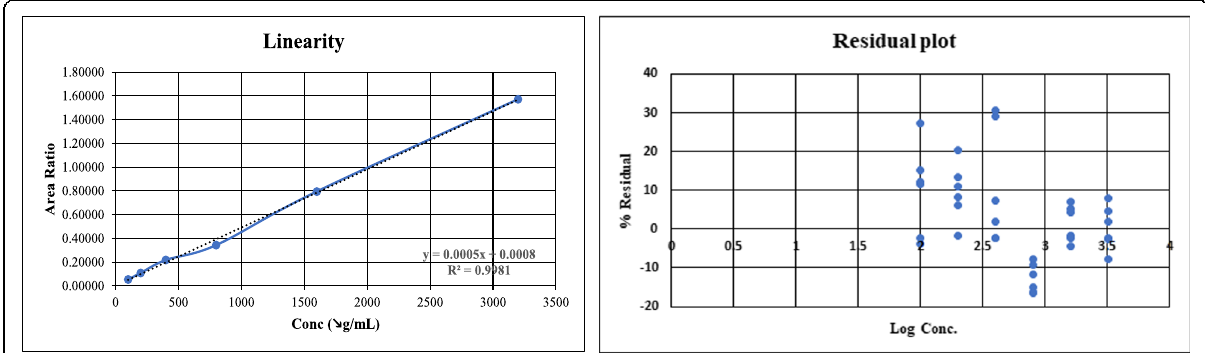
Fig. 1 Calibration curve and residual plot of chlorthalidone, make the correction of x-axis title of linearity Conc (ug/mL) (symbolic microgram per mL)